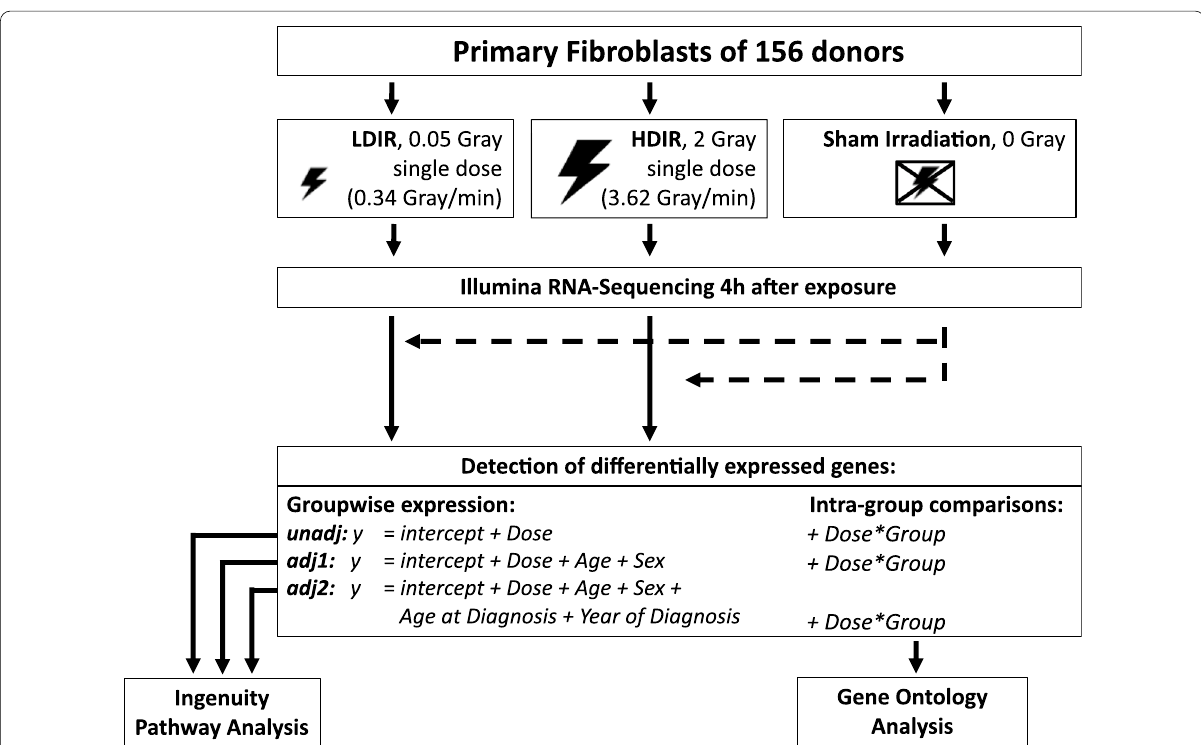
Fig. 1 Experimental workflow. Primary fibroblasts of all donors were processed as matched triplets consisting of a donor with a first primary neoplasm only, a donor with a second primary neoplasm and a cancer‑free control. The triplets were exposed to a low dose of ionizing radiation (LDIR, 0.05 Gray), a high dose of ionizing radiation (HDIR, 2 Gray), or were sham‑irradiated (0 Gray). mRNA was extracted 4 h after exposure, Illumina‑sequenced, and processed for the investigation of differentially expressed genes for each donor with regard to the regulation/level in sham‑irradiated cells (dashed arrows). Differentially expressed genes as a result of groupwise‑expression models were further subjected to Ingenuity Pathway Analysis and resulting gene‑sets of the intra‑group comparisons were analyzed for over‑representation using the Gene Ontology